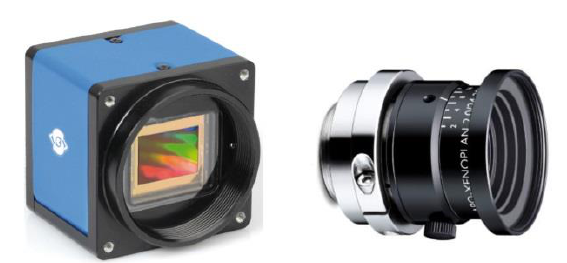
Figure 1: Industrial grade camera